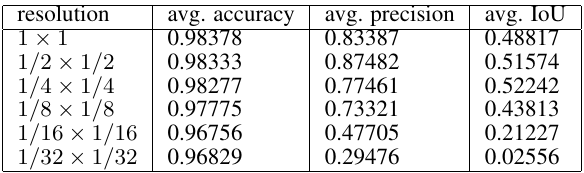
Table 1. Performance of window detection with Faster R-CNN on the ICG Graz50 dataset using different image resolutions.